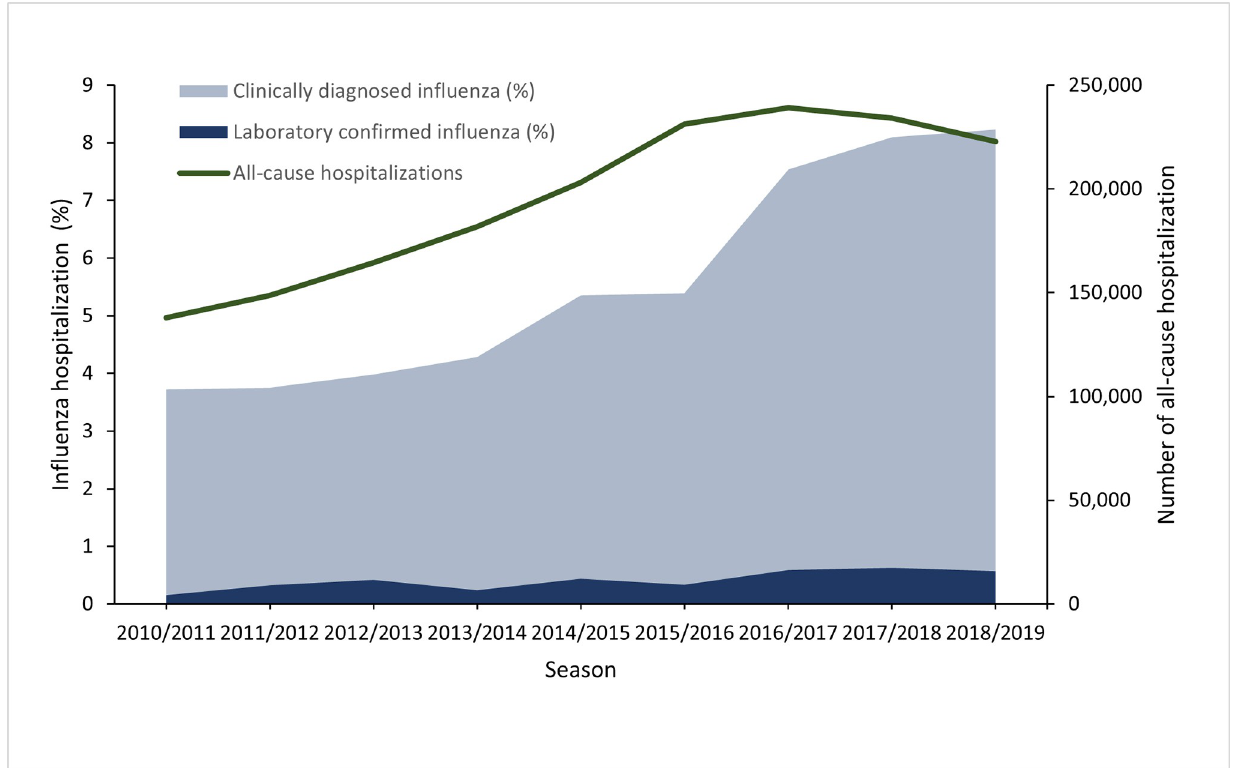
Fig 1. The number of all-cause hospitalizations and proportion of hospitalizations for clinicaly diagnosed influenza and laboratory-confirmed influenza. The percentage refers to the number of clinically diagnosed influenza and laboratory-confirmed influenza cases divided by the total number of all-cause hospitalizations recorded for that